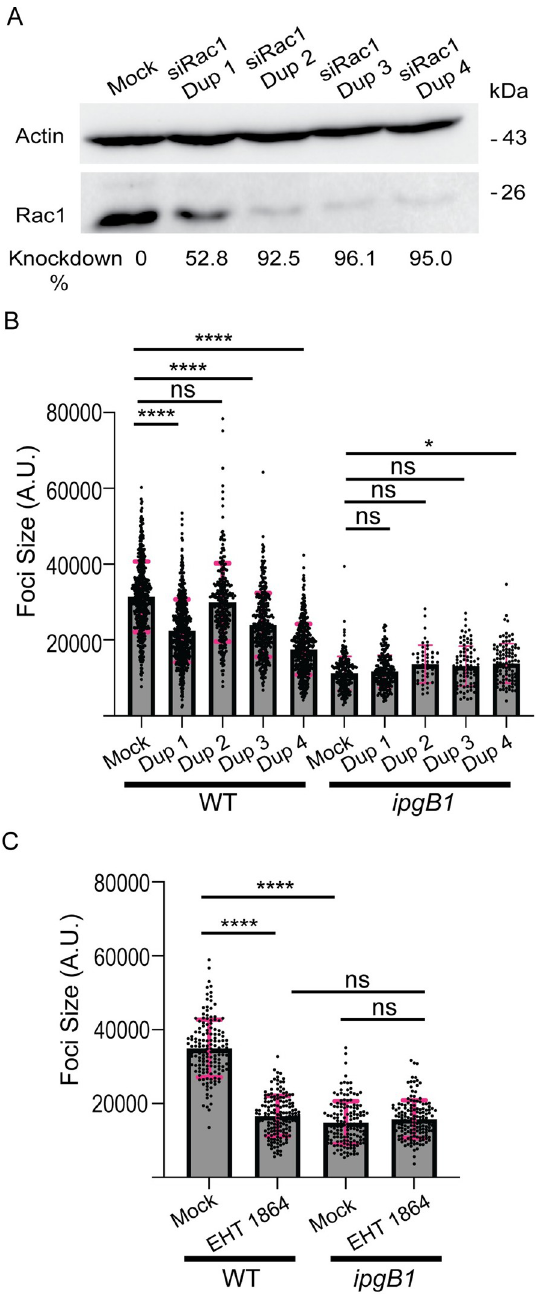
Fig 3. Rac1 signaling is required for efficient cell-to-cell spread. (A) Western blot showing knockdown efficiency of four siRNA duplexes targeting Rac1. Rac1 (bottom panel) was normalized to loading control (actin, top panel) and knockdown efficiency of was calculated relative to mock treated cells. (B) Quantification of foci size at 16 hr postinfection of wild type or ipgB1 bacteria in mock treated cells or upon Rac1 depletion with four siRNA duplexes. (C) Quantification of wild type or ipgB1 foci size at 16 hr postinfection in either cells treated with DMSO control or with 20 μ M EHT 1864. For (B and C), at least three independent biological replicates were performed, each containing at least 50 foci. Each point represents one focus and the grey bars represent the mean foci size. Error bars represent the standard deviations; one-way ANOVA was performed with Dunnett’s multiple comparisons test; ns, not significant; � , p < 0.05; ���� , p <